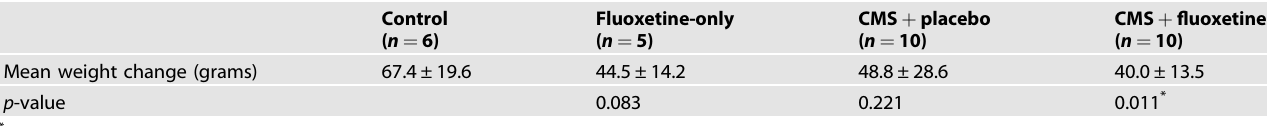
Table 2. Comparison of body weight of the control group versus the fl uoxetine-only, CMS + placebo and CMS + fl uoxetine groups at 4